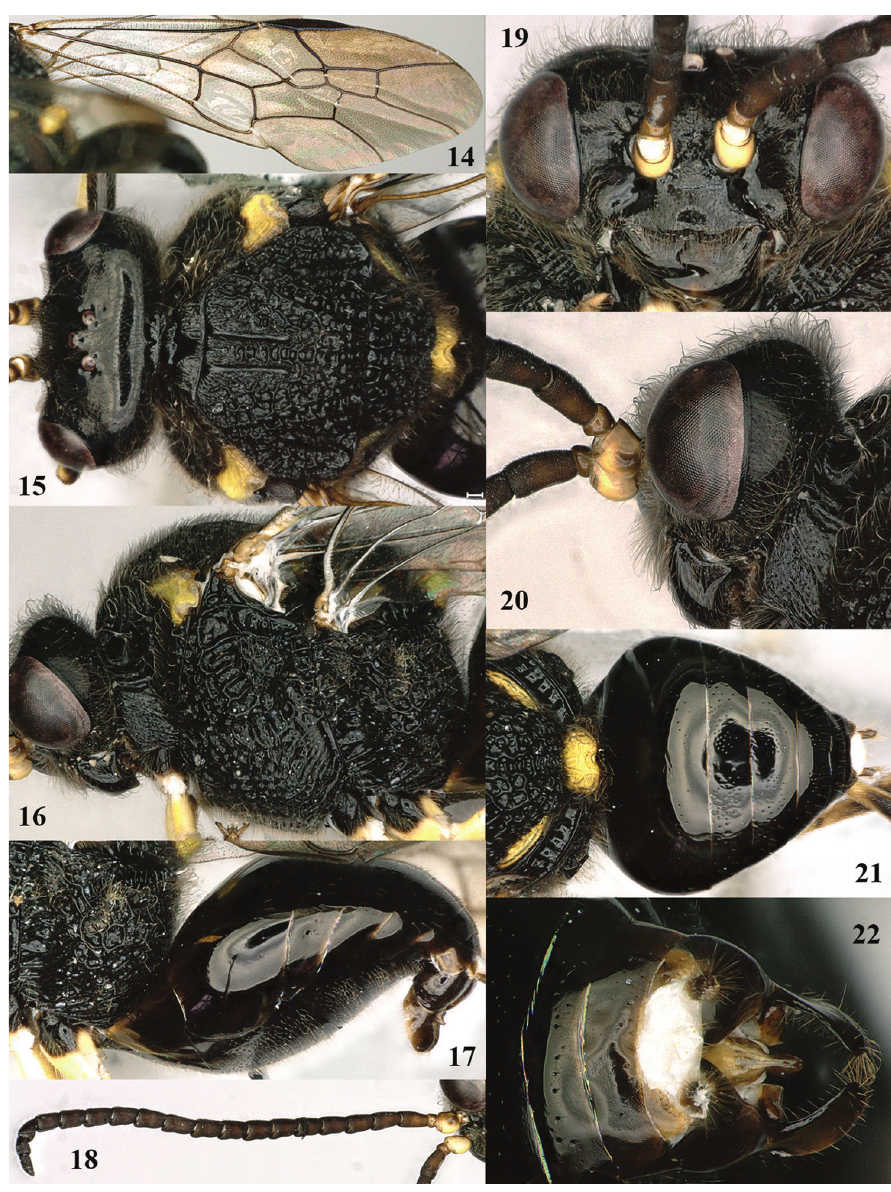
15 head and mesosoma dorsal 16 mesosoma lateral 17 metasoma lateral 18 antenna lateral 19 head anterior 20 head lateral 21 metasoma dorsal 22 genitalia dorsal. tirely black or mesoscutum with pair of tiny yellow spots anteriorly and second sternite with pair of medium sized yellow spots; veins 1-SR, 1-M and 1-SR+M of fore wing dark brown. Genitalia, see Fig.